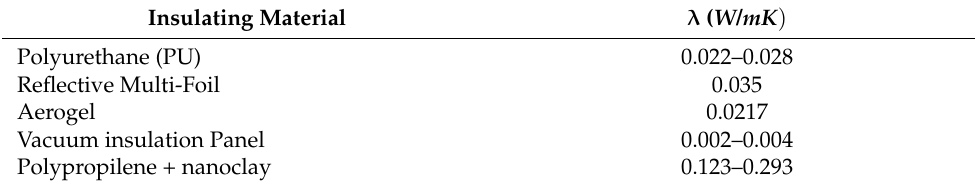
Table 16. Thermal conductivity of the insulating materials